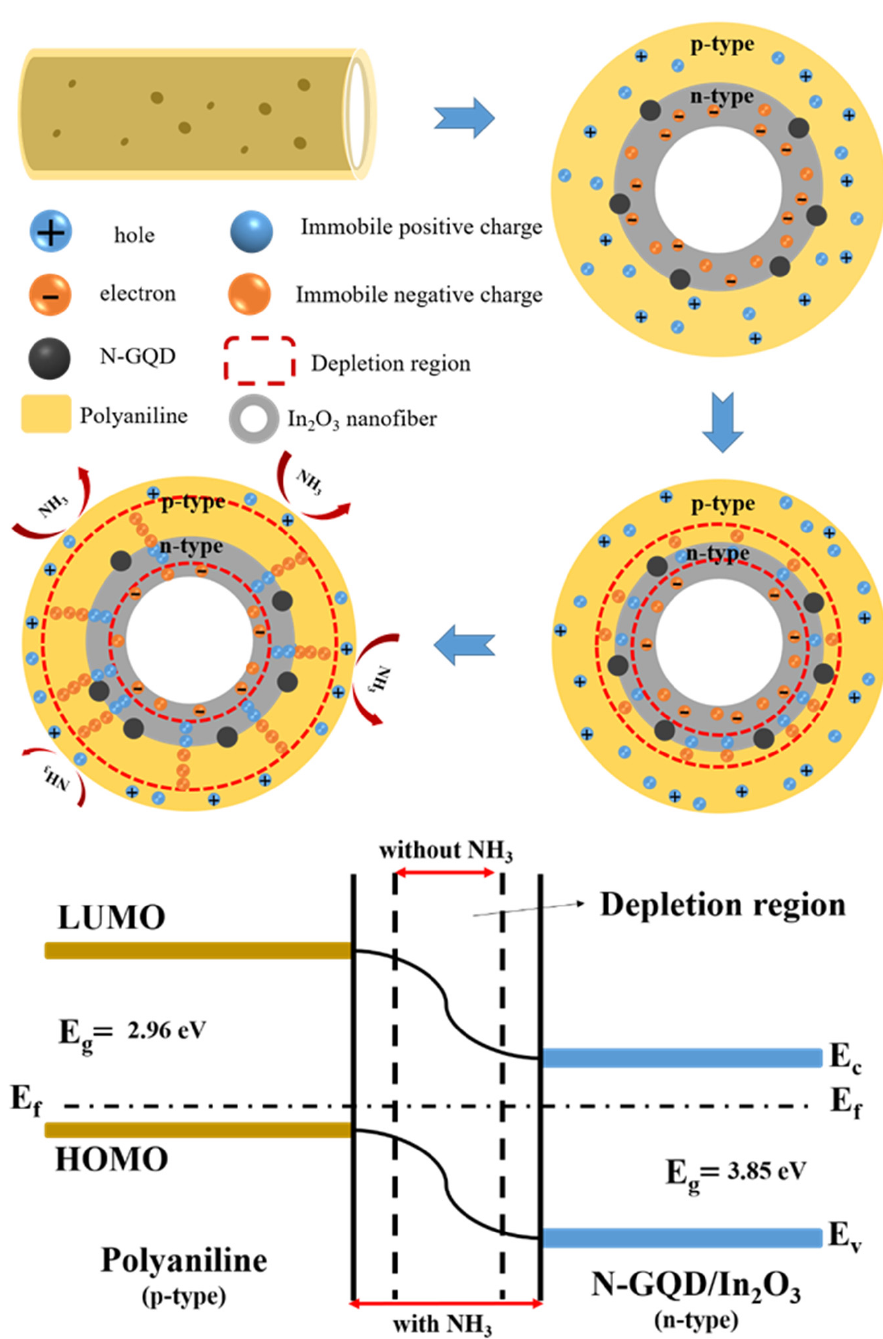
Figure 10. The schematic illustration of the sensing mechanism and energy band gap structure diagram of PANI/GQD/hollow In 2 O 3 nanofiber composite sensors.